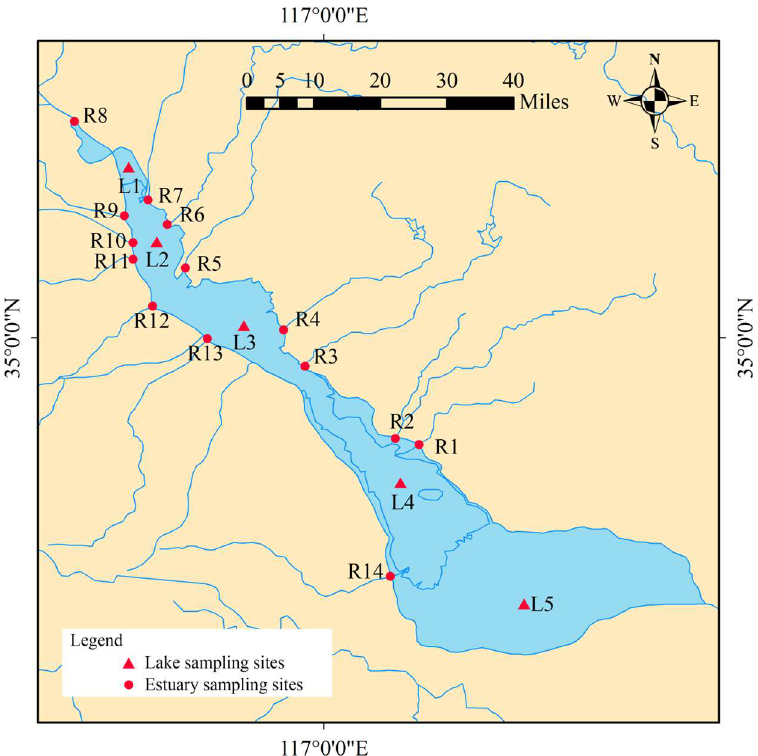
Figure 1. Location map of the sampling sites.